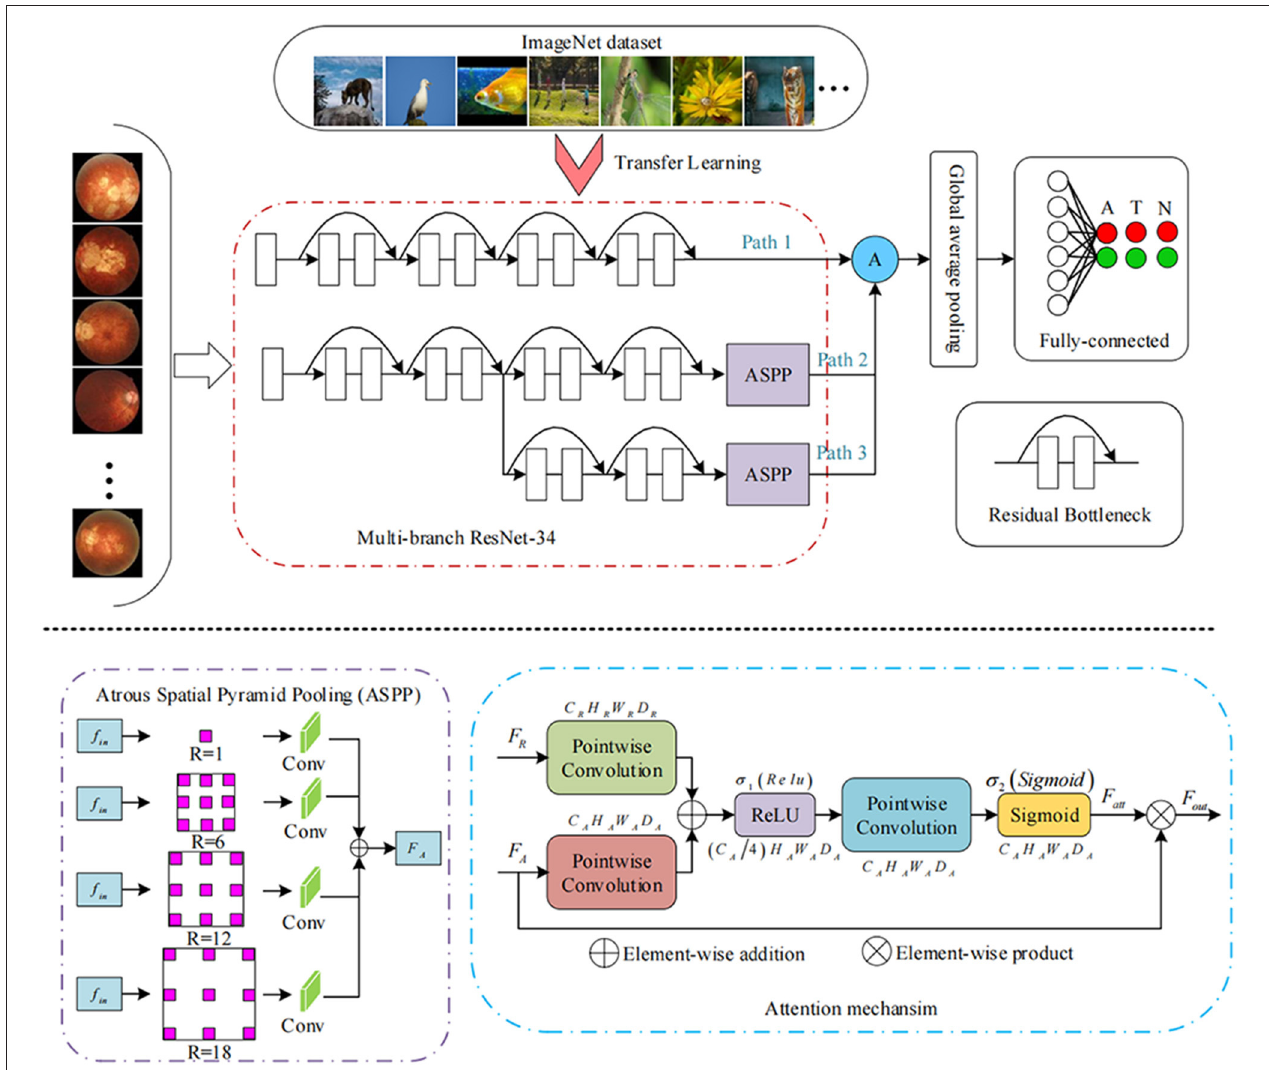
FIGURE 3 | Framework of the deep learning